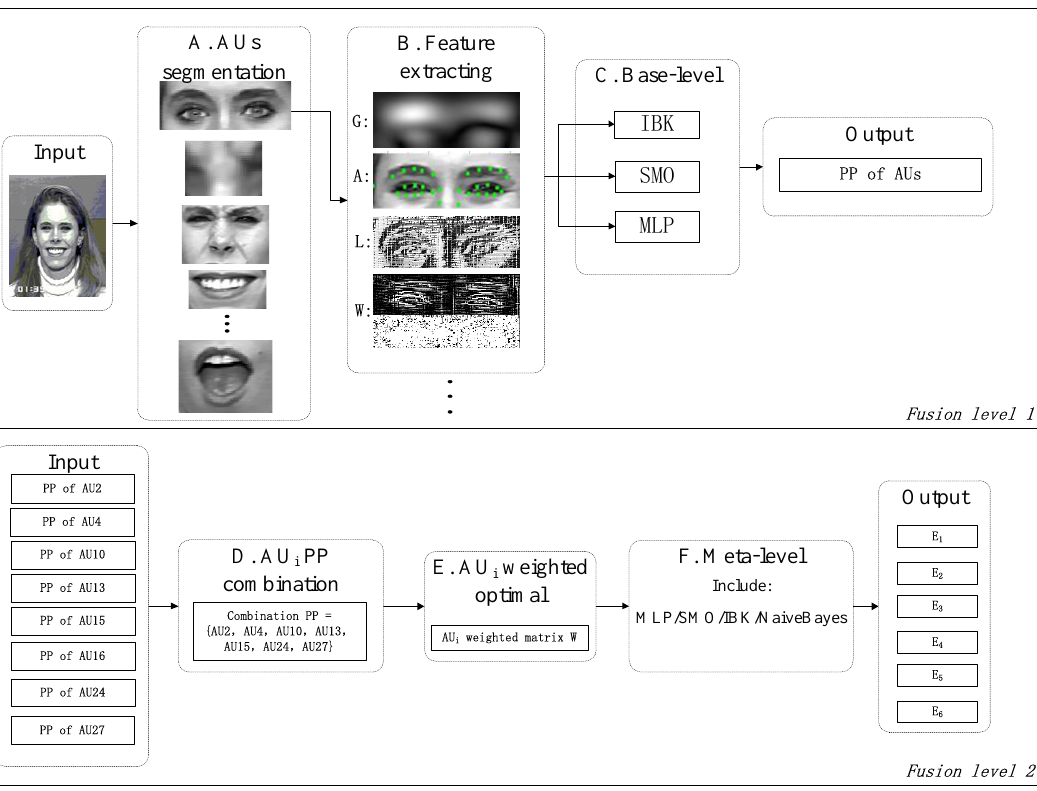
Figure 7. Multi-level fusion model of expression recognition.